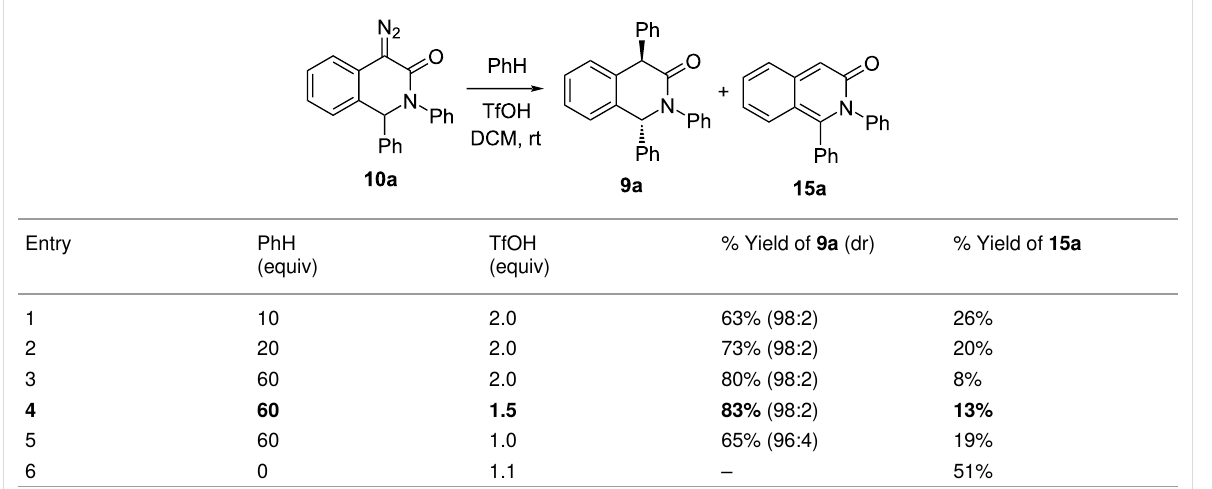
Table 1: Conditions screening for the TfOH-promoted arylation of diazo substrate 10a . a